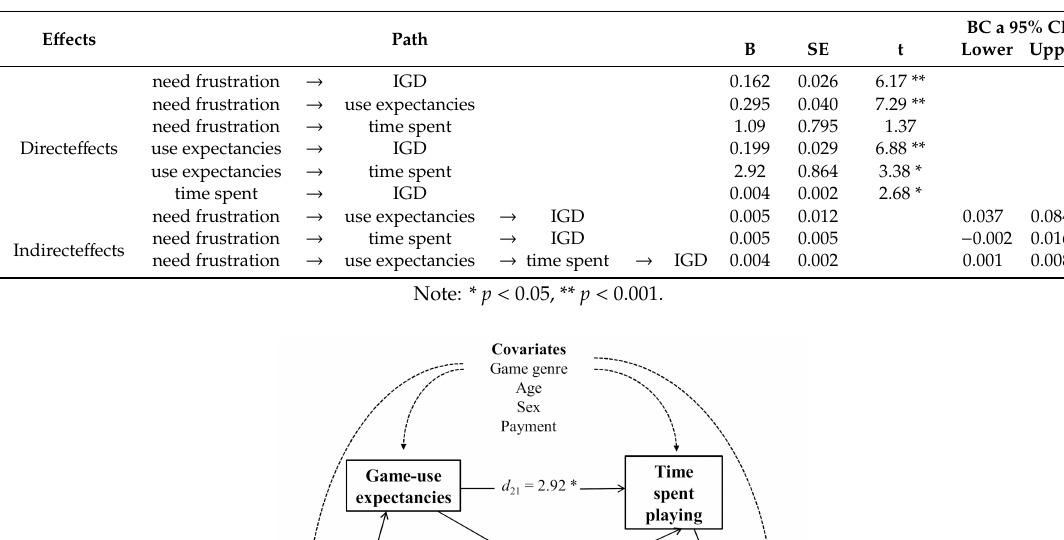
Table 3. Summary of serial mediation analysis of game expectancies and engagement between need frustration and Internet gaming disorder (IGD) (n = 471, bootstrap = 5000).